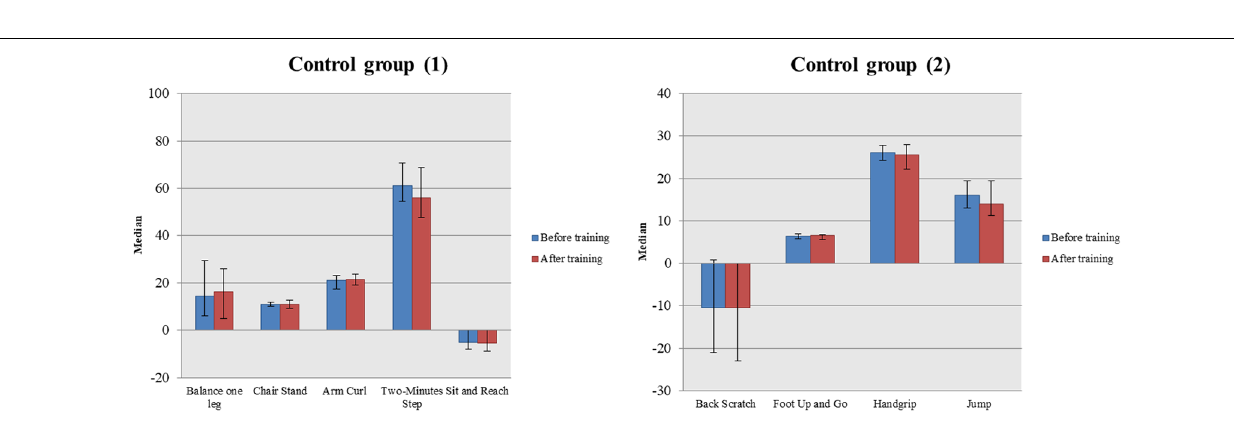
FIGURE 4 | Comparison in somatometric data of the control group in two-time conditions (before and after the waiting